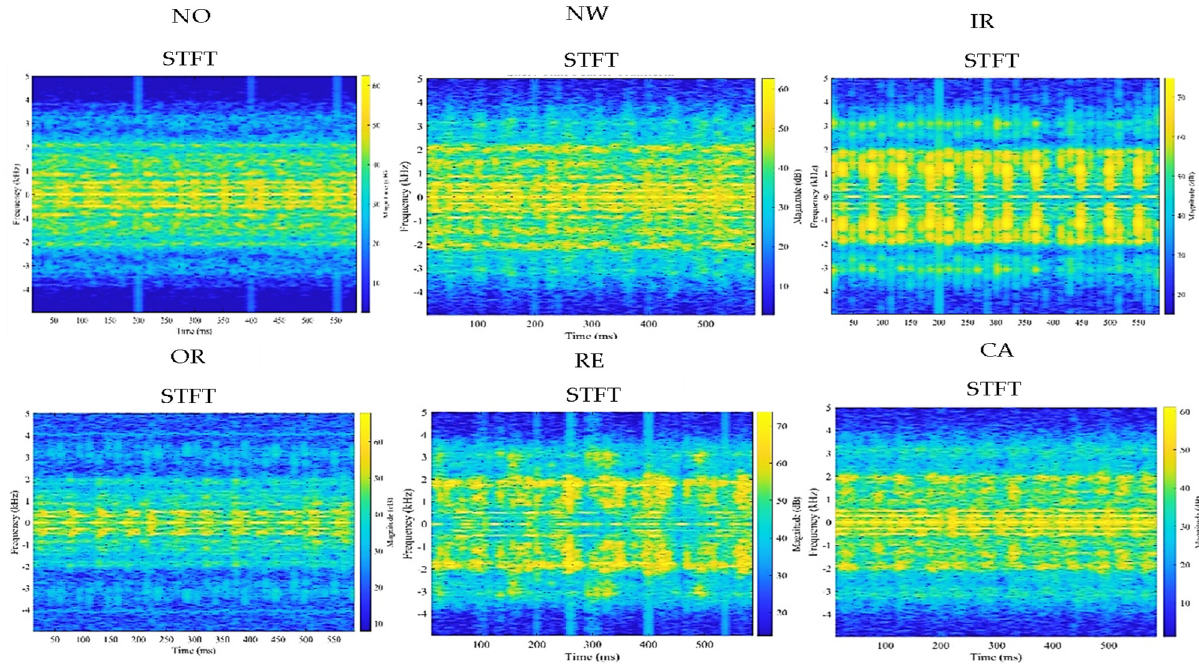
Figure 18. Examples of the generated vibration image using the STFT technique, using a Kaiser window of length 256 and a shape parameter β = 5.